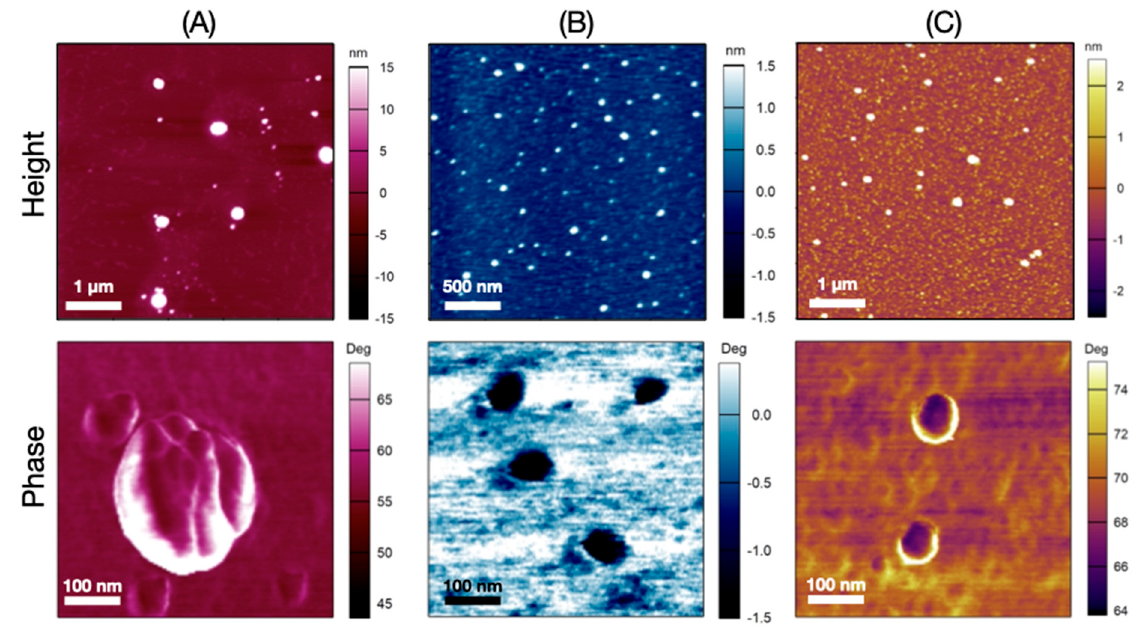
Figure 5. AFM images of height of: ( A ) CGAc AmB, ( B ) CGProp AmB, and ( C ) CGBut AmB nano- particles.